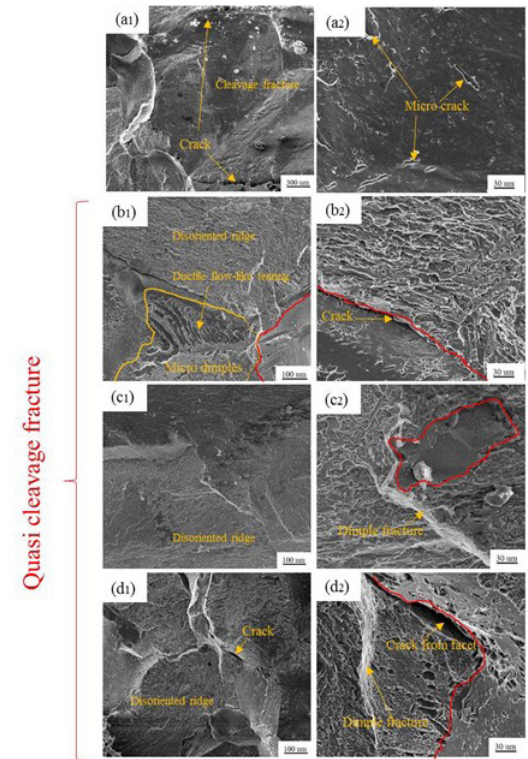
Figure 11. SEM fractographs, (a1, a2) 1mm/120s, (b1, b2) 2mm/120s, (c1, c2) 3mm/120s and (d1, d2)